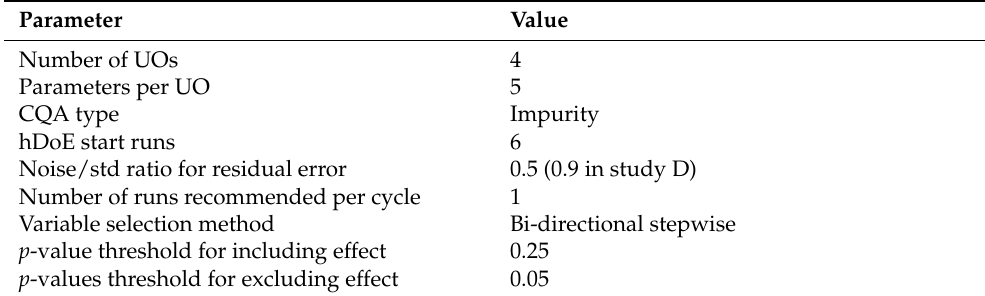
Table 1. Parameters for the simulation